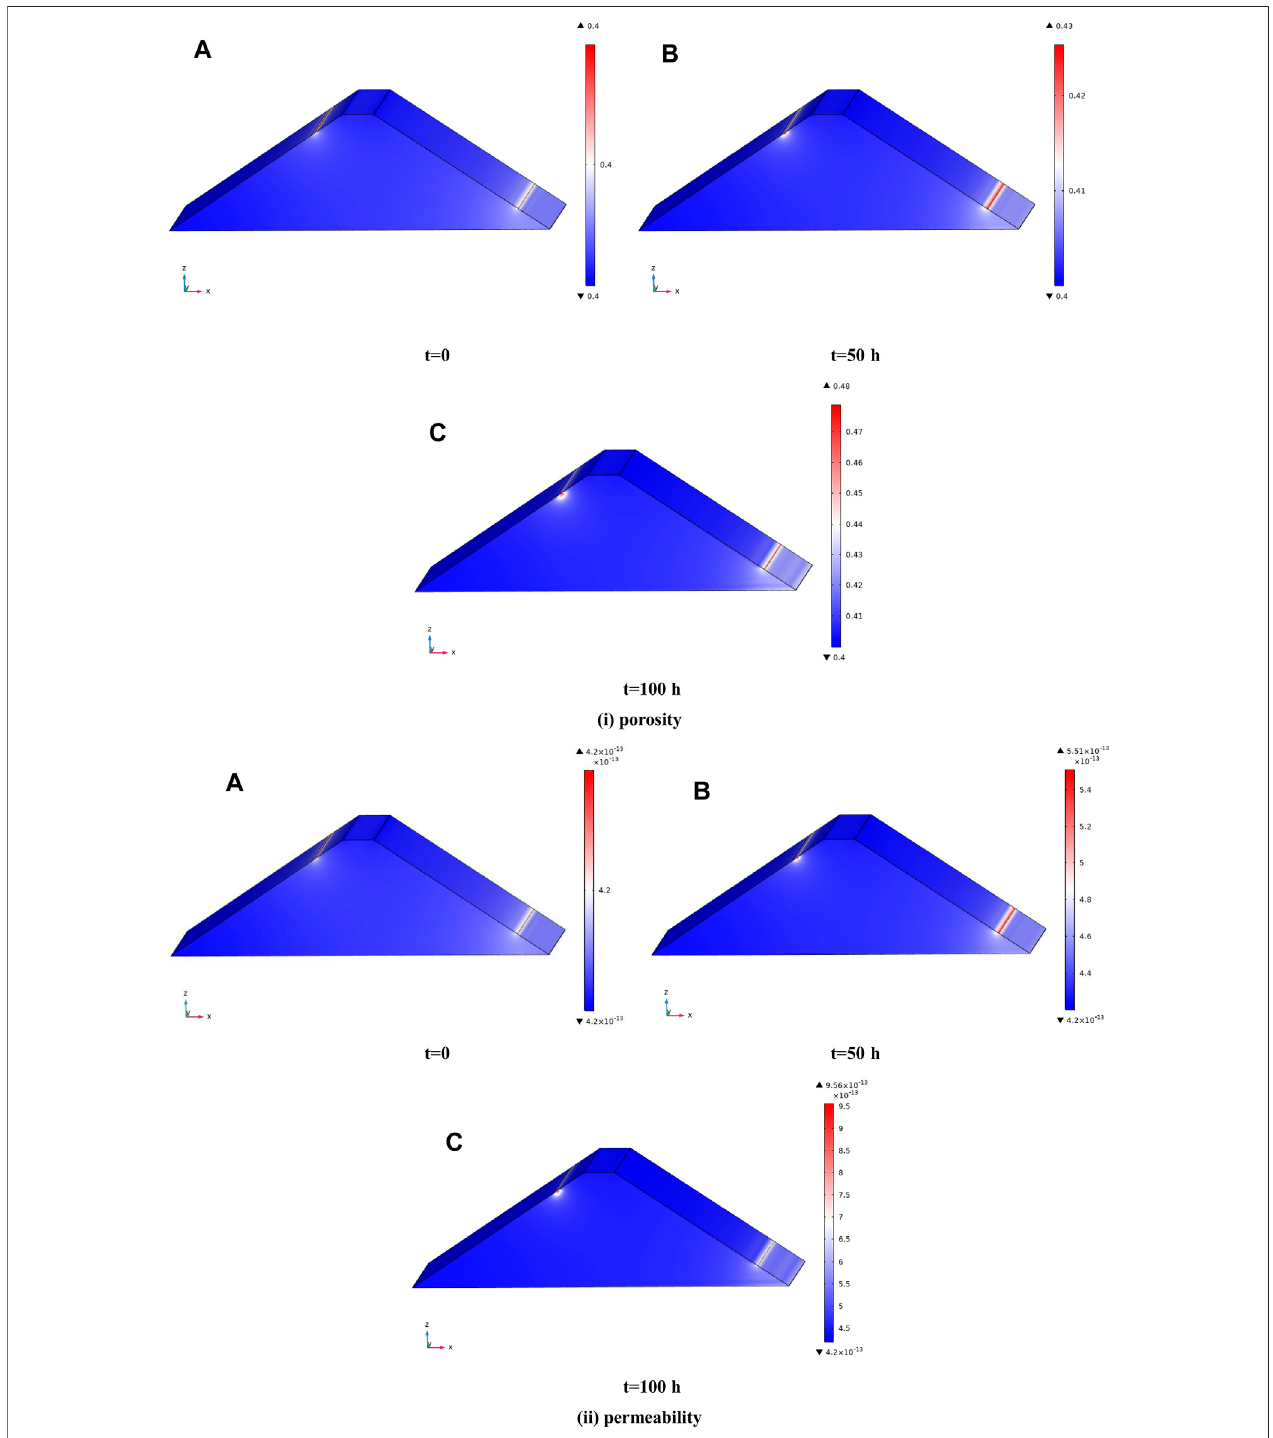
FIGURE 9 | Spatial distribution of porosity and permeability in the embankment dam slope. (A) t = 0, (B) t = 50 h, (C) t = 100 h, (i) porosity, and (ii) permeability.